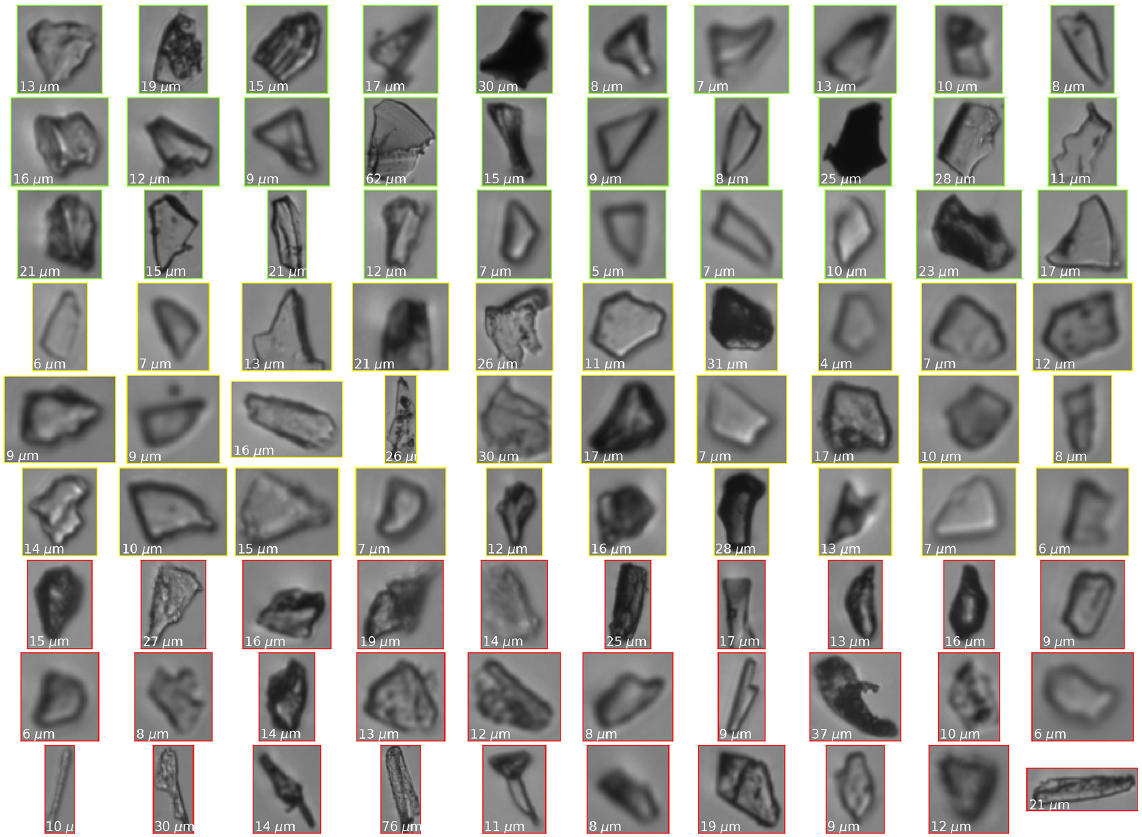
Figure 7. A random subset of the AI-predicted tephras in the 3136 0–20cm GRIP sample assessed by Human1, color-coded according to the given validation of yes (green), maybe (yellow), or no (red). The particle diameters (ABD) are shown in the bottom-left